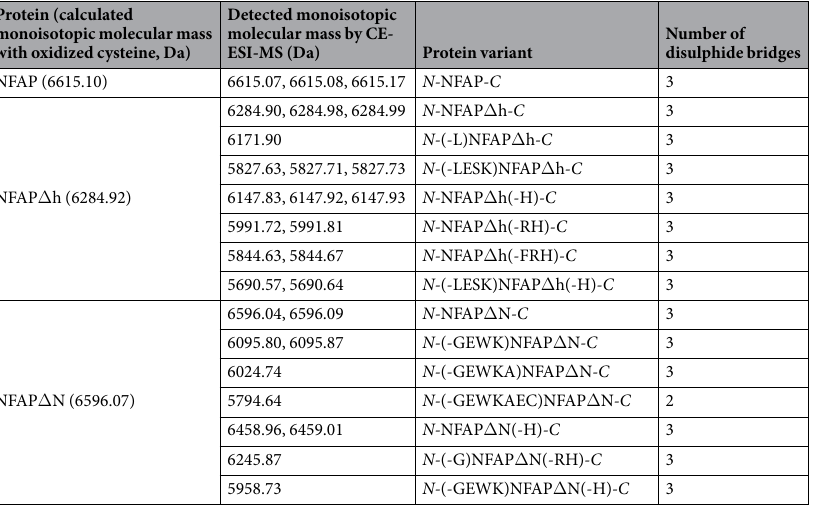
Table 2. Calculated and detected monoisotopic molecular masses (in the range of 5600–7400 Da) of the recombinantly expressed proteins that were purified from four days old Pichia pastoris KM71H supernatants. NFAP: recombinant Neosartorya fischeri NRRL 181 antifungal protein (n = 3); NFAP ∆ h: hydrophobic